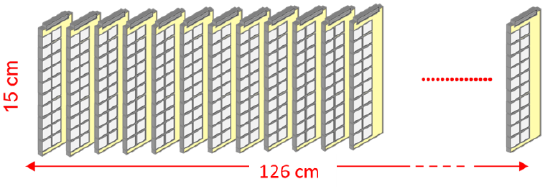
Fig. 5. Schematic layout of the PID-wall